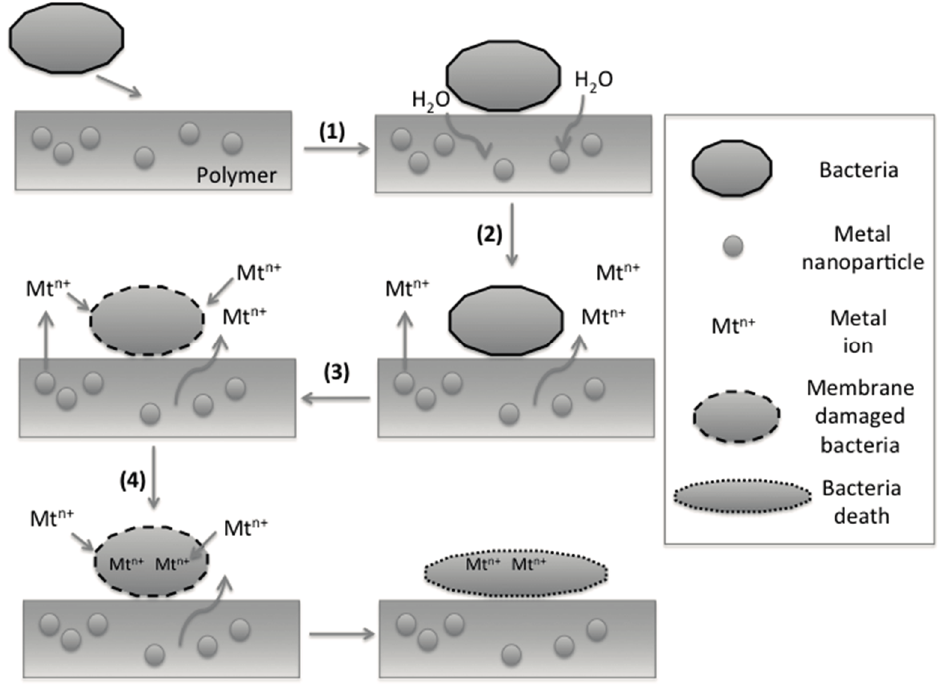
Figure 4. Mechanisms for the antimicrobial behavior of polymer/metal nanocomposites based on thermoplastic matrices: ( 1 ) adsorbtion of bacteria on the polymer surface triggering the diffusion of water through the polymer matrix due to the medium surrounded the bacteria; ( 2 ) water with dissolved oxygen reaches the surface of embedded metal nanoparticles allowing dissolution or corrosion processes and in this way metal ions are realized; ( 3 ) metal ions reach the composite surface damaging the bacteria membrane; ( 4 ) Afterward, metal ions can diffuse into the bacteria. The details of the specific mechanisms are explained in Figure 1. Although this figure represents a polymer nanocomposite, it can be extrapolated to any polymer/metal materials with the biocide agent embedded in the